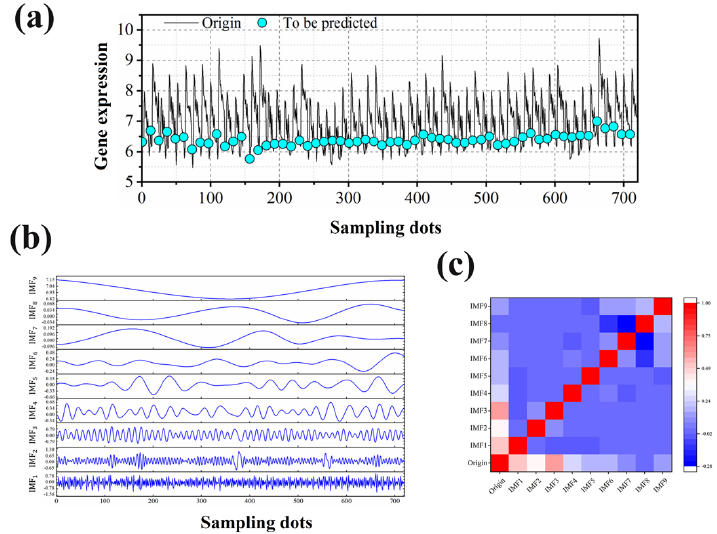
Figure 2. EMD-based decomposition of the original data. ( a ) Expression of the genes to be analyzed. The data to be predicted are highlighted with blue dots. ( b ) The results obtained from the original data based on EMD decomposition for each component of IMF 1 -IMF 9 . ( c ) Spearman correlation of each component of IMF 1 -IMF 9 after EMD decomposition with the original data.